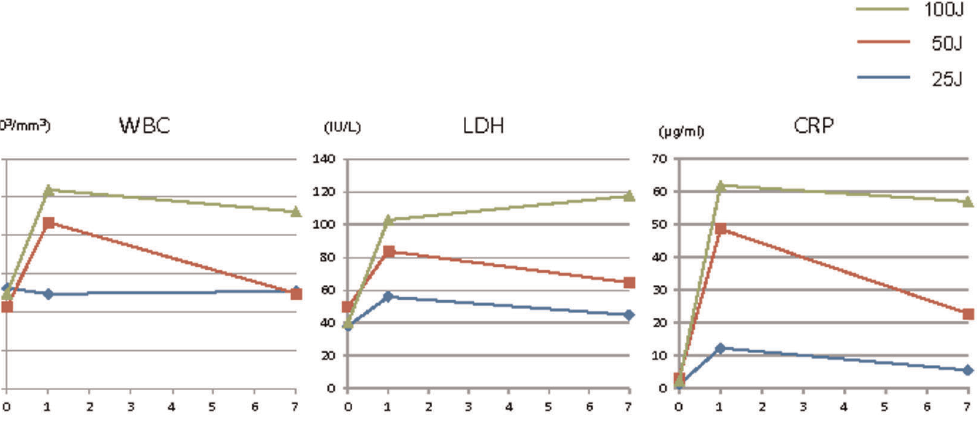
Figure 1. Laboratory data before and after irradiation. Compared with the baseline values, WBC count and CRP and LDH concentrations were increased with increasing radiation dose. WBC count and CRP and LDH concentrations returned to the baseline values on day 7 in the 25 J/cm 2 group but remained high, especially in the 100 J/cm 2 group.